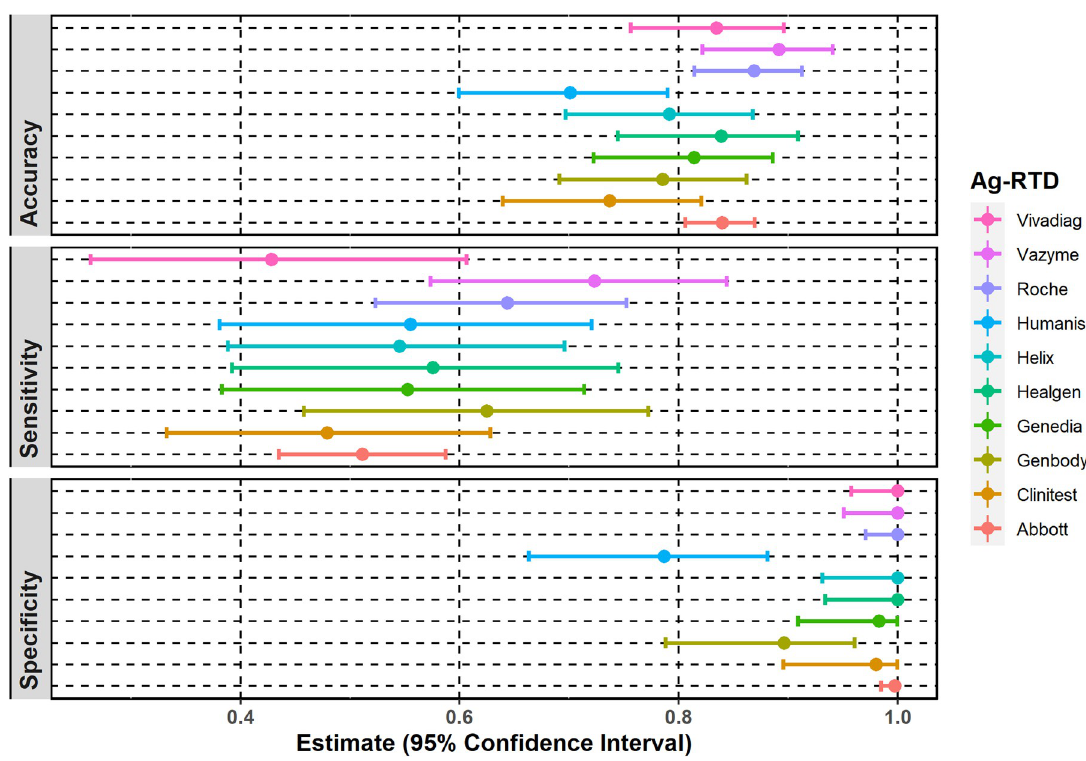
Fig 2. Sensitivity, specificity, and accuracy of each examined antigen rapid test. Point estimates with 95% exact binomial confidence intervals for sensitivity and specificity.